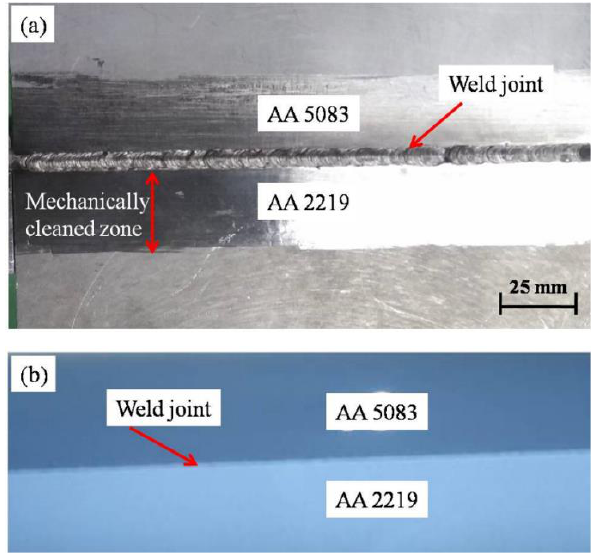
Figure 2. Visual appearance of dissimilar weld joint. ( a ) Top side; ( b ) X-ray radiograph.